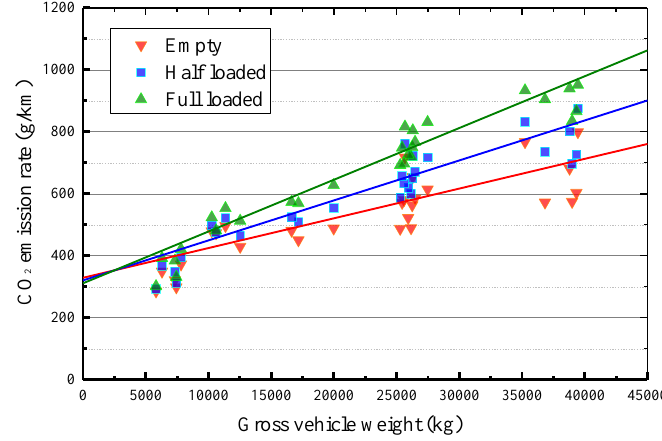
Figure 6. The CO 2 emissions according to loading conditions.